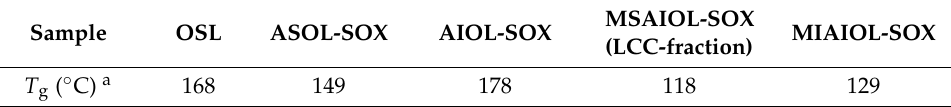
Table 3. Glass transition temperatures of WS-OSL and fractions delineated